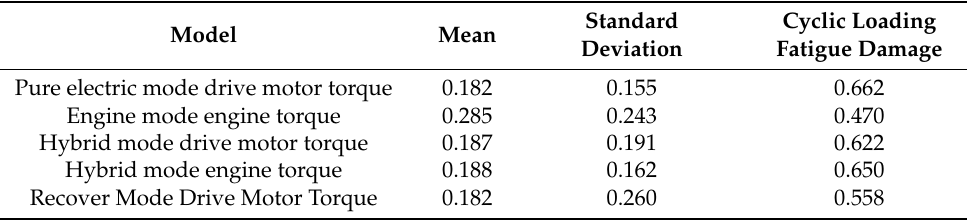
Table 4. Optimal weight coefficients of 5 working mode data.